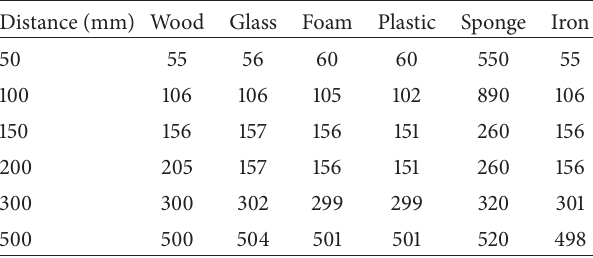
Table 3: US-100 testing results for different materials.